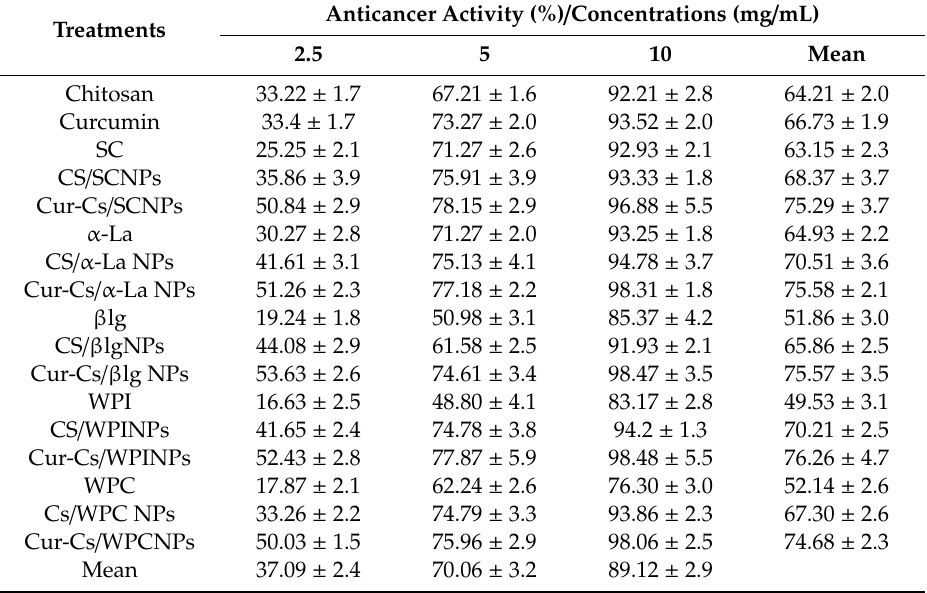
Table 4. Anticancer activity of di ff erent concentrations of native proteins, chitosan–milk protein nanocomposite and curcumin-loaded milk protein nanoparticles against MCF7 cell lines.